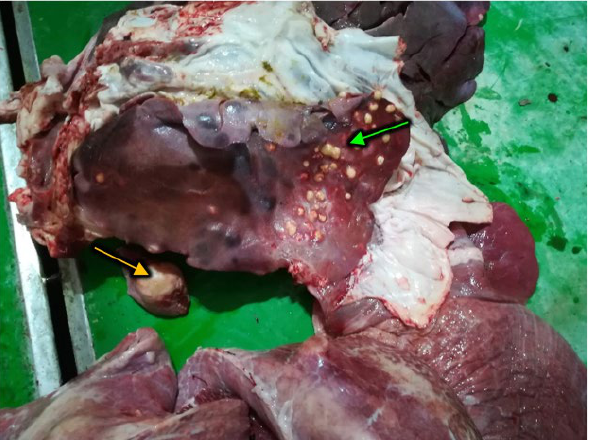
Figure 4. Liver lesions, consistent with the presence of an Echinococcus granulosus cyst (yellow arrow) complicated by a bacterial infection (presence of caseating abscesses, green arrow). Fasciolosis due to Fasciola hepatica was the major lesion in March (1.9%), with a peak in November (2.2%). The hepatic tuberculosis cases were not often observed, the only records were reported in November, with a low prevalence